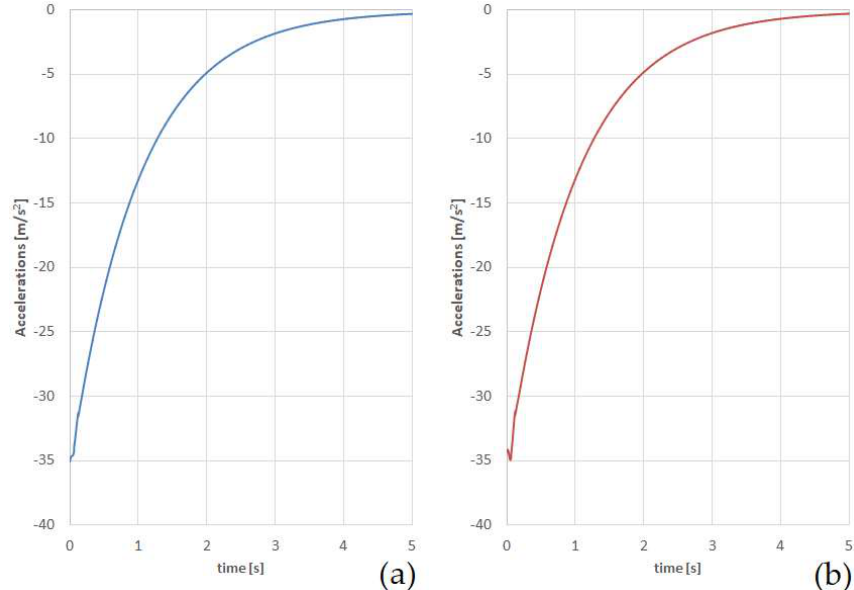
Figure 6. Accelerations on the carrying structure of the articulated flat wagon: ( a ) first and ( b ) second sections of the flat wagon from longitudinal force. Table 1. Numerical values of accelerations on the carrying structure of articulated circular-tube wagons.